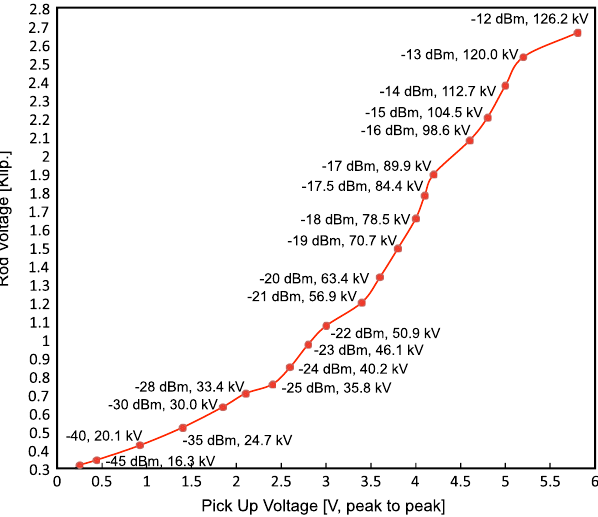
FIG. 24. A plot of the interrod voltage as a function of the pickup voltage. Decibel values refer to a signal generator (SG) output level to the rf